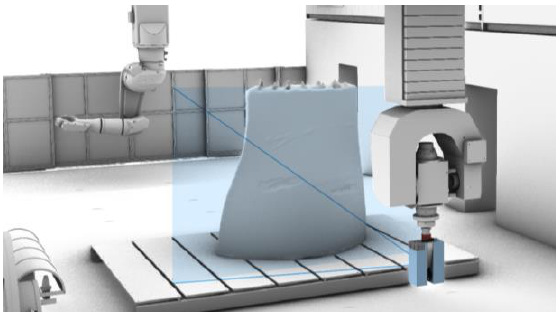
Figure 1 . TLS mounted on the fabrication